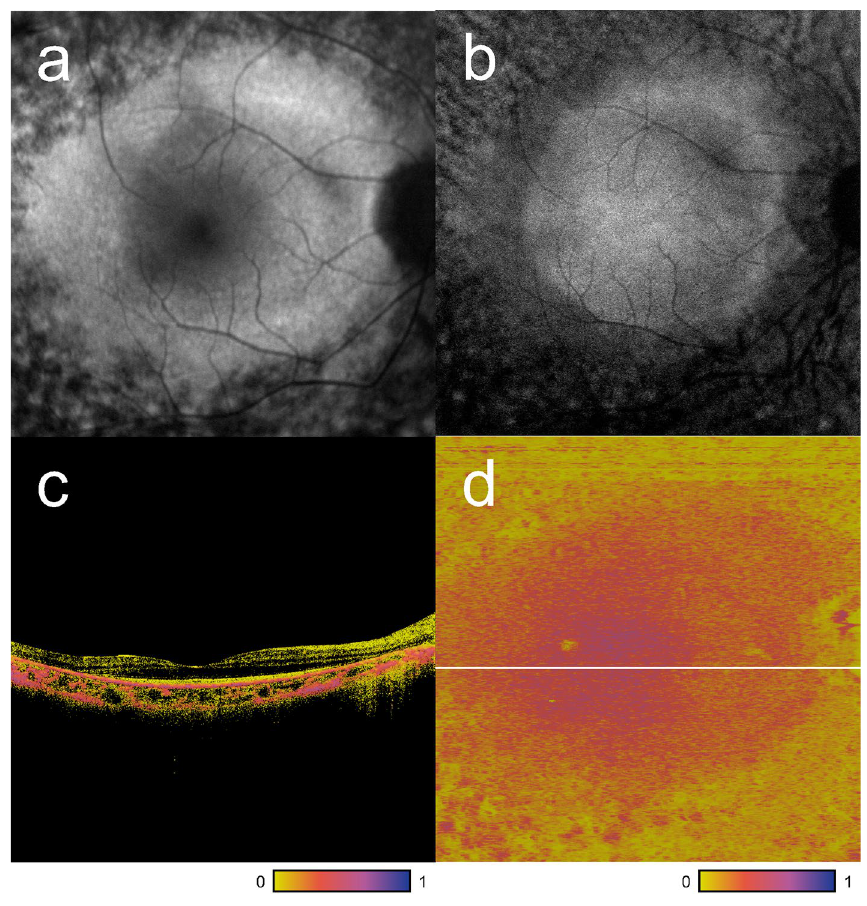
Figure 1. Representative images of multimodal retinal imaging. ( a ) Short-wavelength autofluorescence (AF). ( b ) Near-infrared AF image. ( c ) Polarization-sensitive optical coherence tomography (PS-OCT) B-scan image along the horizontal meridian through the fovea. ( d ) En face PS-OCT image which is extracted at the RPE level of patient 1. The white line is a trace line of the B-scan image ( c)